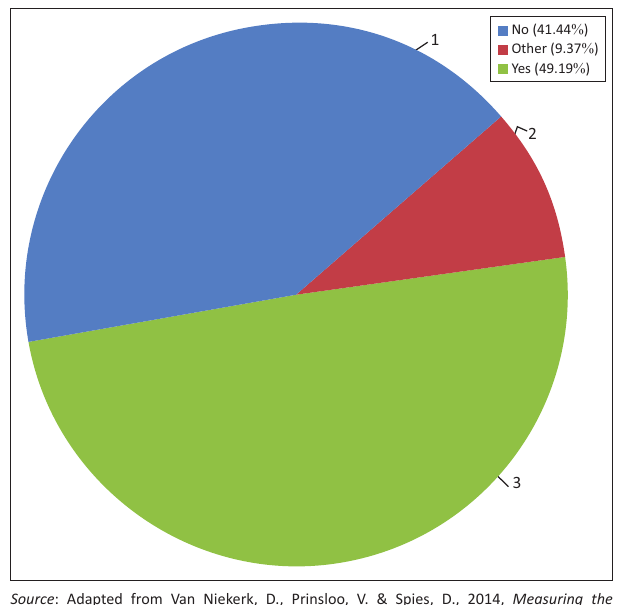
FIGURE 8: The perceived usefulness of planting with the first rains.